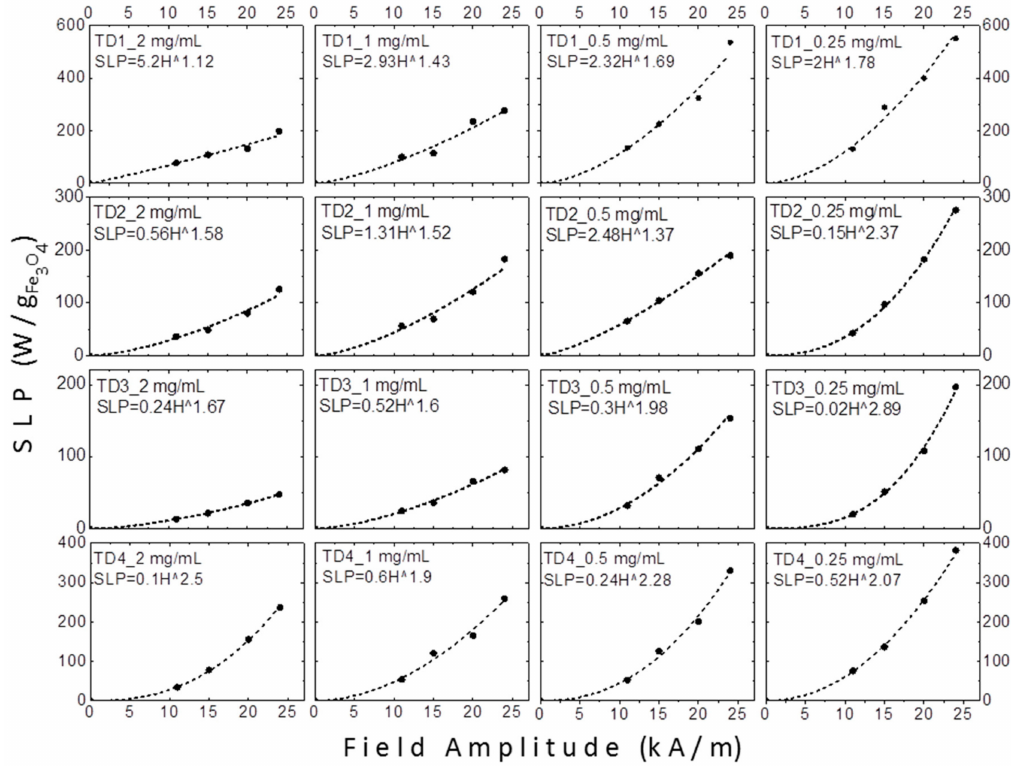
Figure 12. The SLP values of TD1–TD4 at four di ff erent concentrations (2, 1, 0.5, and 0.25 mg / mL) versus the amplitude of the applied field in kA / m. On each graph the formula which approximates the SLP as a function of the field amplitude is